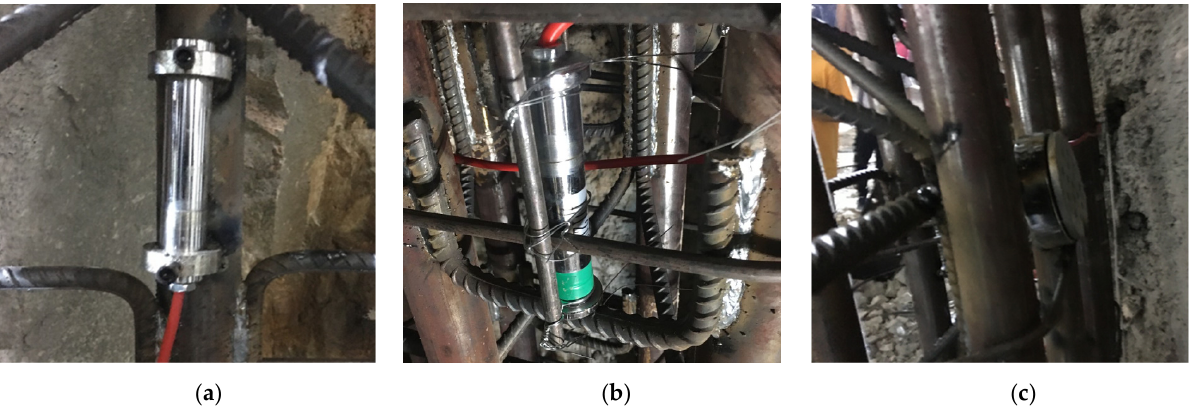
Figure 23. Field installation of monitoring components: ( a ) surface strain gauge, ( b ) concrete strain gauge, ( c ) pressure cell.